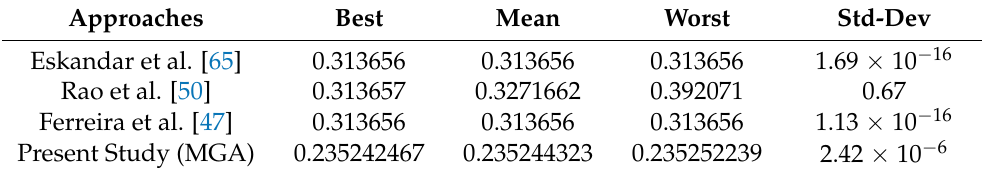
Table 13. Statistical results of different approaches for the multiple disk clutch brake design problem.